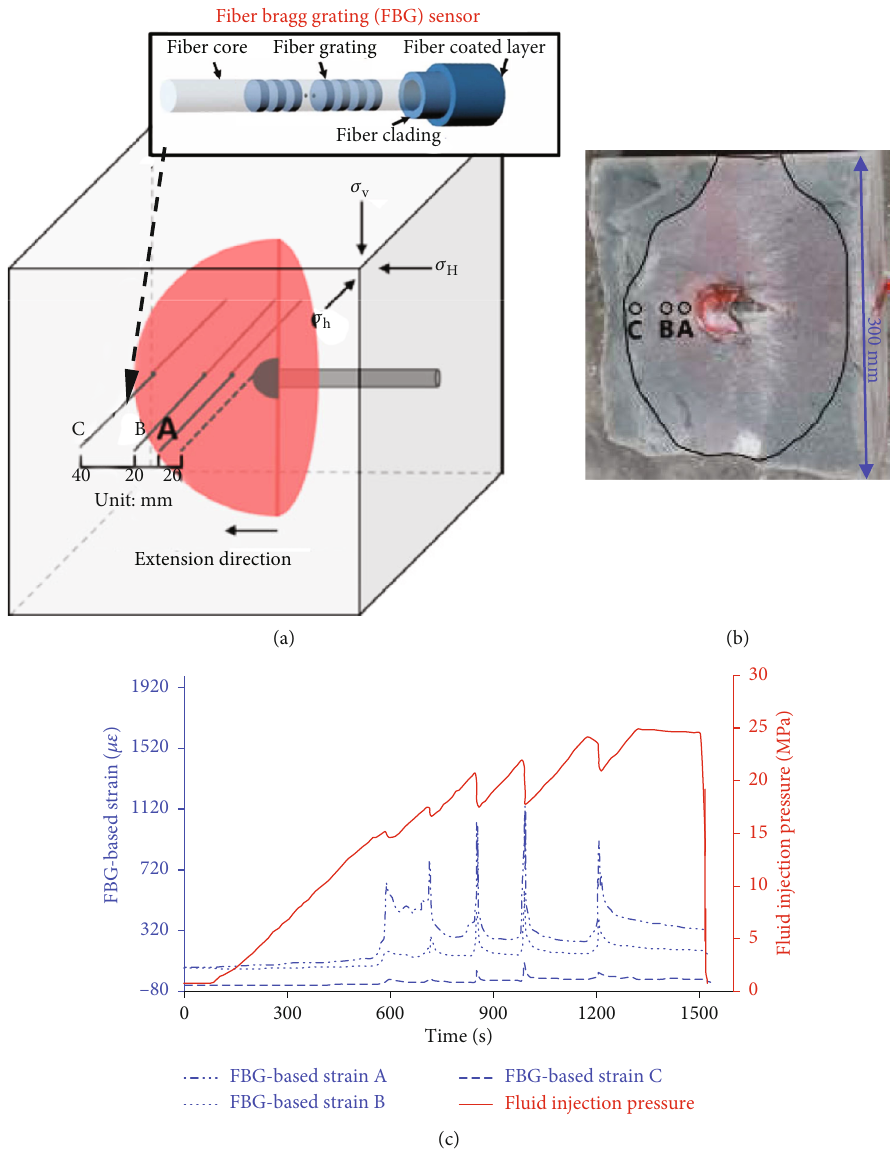
Figure 9: Hydraulic fracture propagation characterized by Fiber Bragg Grating (FBG) sensors (replotted based on the experimental results of Yang et al. [39]): (a) the layout of FBG sensors; (b) hydraulic fracture surface; (c) FBG-based strains and injection pressures. Table 1: Experimental programs of de fl ecting propagation of hydraulic fracture. Group